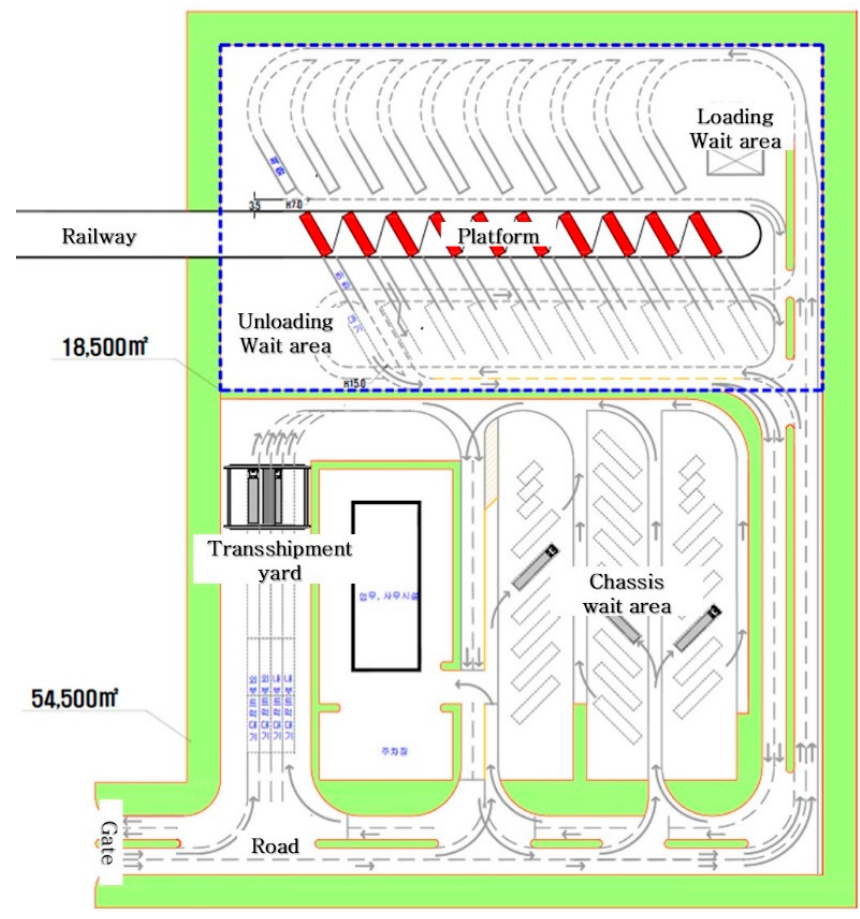
Figure 4. Standard layout of ACTS terminal.